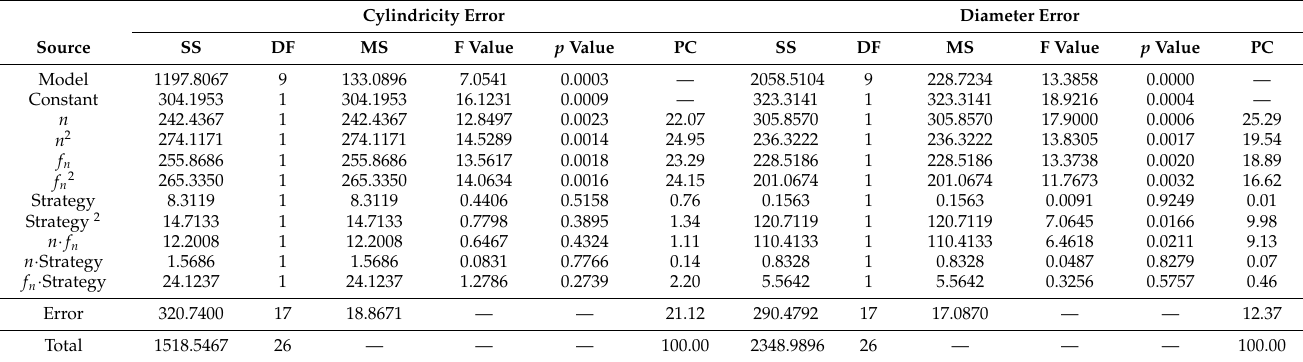
Table 4. Results of the statistical analysis, ANOVA, for the hole cylindricity and diameter